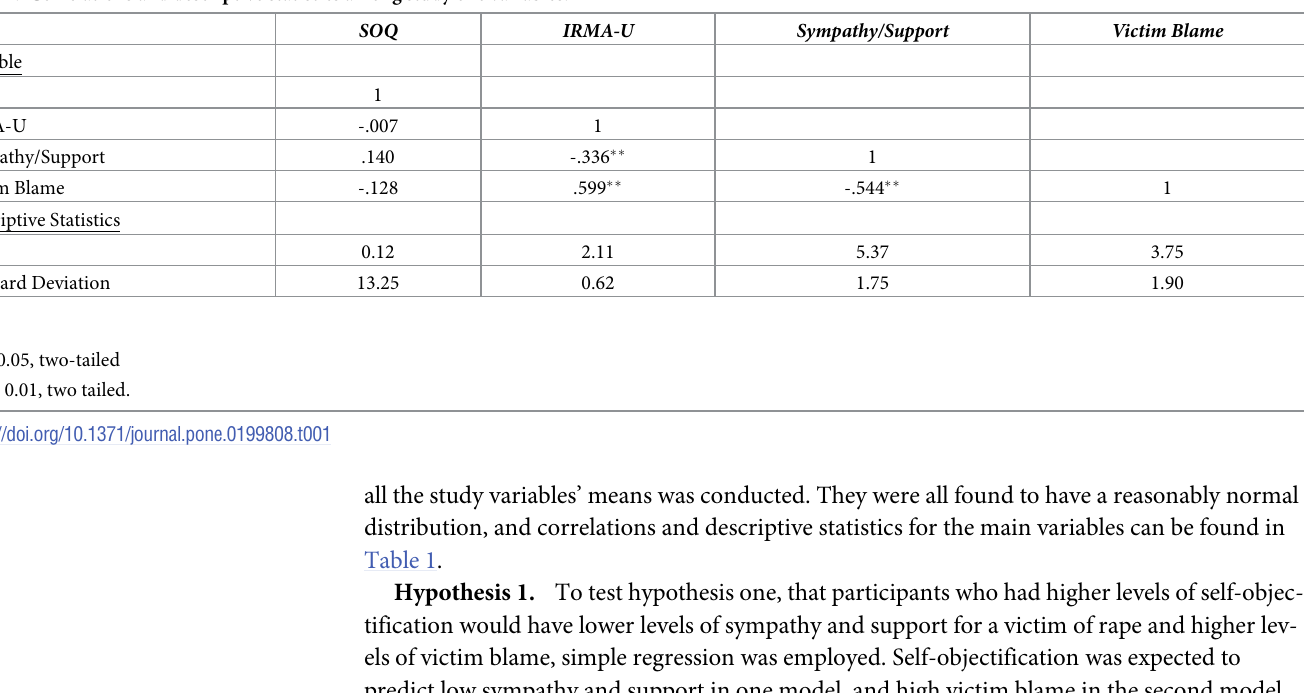
Table 1. Correlations and descriptive statistics among study one